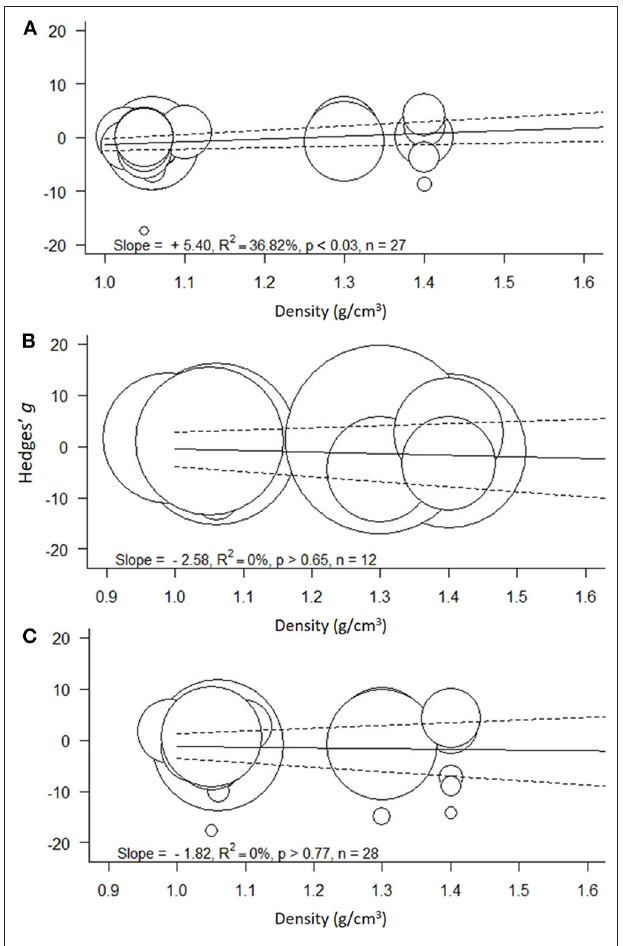
FIGURE 4 | Meta-regressions for the effect size as a function of polymer density (g/cm 3 ) across the models: (A) Low concentration model ( < 100 mg/L), (B) High concentration model ( 100 mg/L), and (C) Full range model ≥ (0.004–1,100 mg/L). Circle size indicates the study weight in the effect size calculation; note that the scale for the weights varies among the models. Solid line represents model prediction and dashed line is the corresponding 95% CI. FIGURE 5 | Subgroup analysis for the particle shape as a predictor for the effect size across the models: (A) Low concentration model ( < 100 mg/L) and (B) Full range model (0.004–1,100 mg/L). Crosses represent the median, the boxes are the 95% CI of the median, and whiskers show the overall 95% CI. The black dots indicate outliers. The horizontal dashed line indicates no effect. N values on the x axis indicate number of entries in each subgroup. The asterisk indicates statistical significance at α =